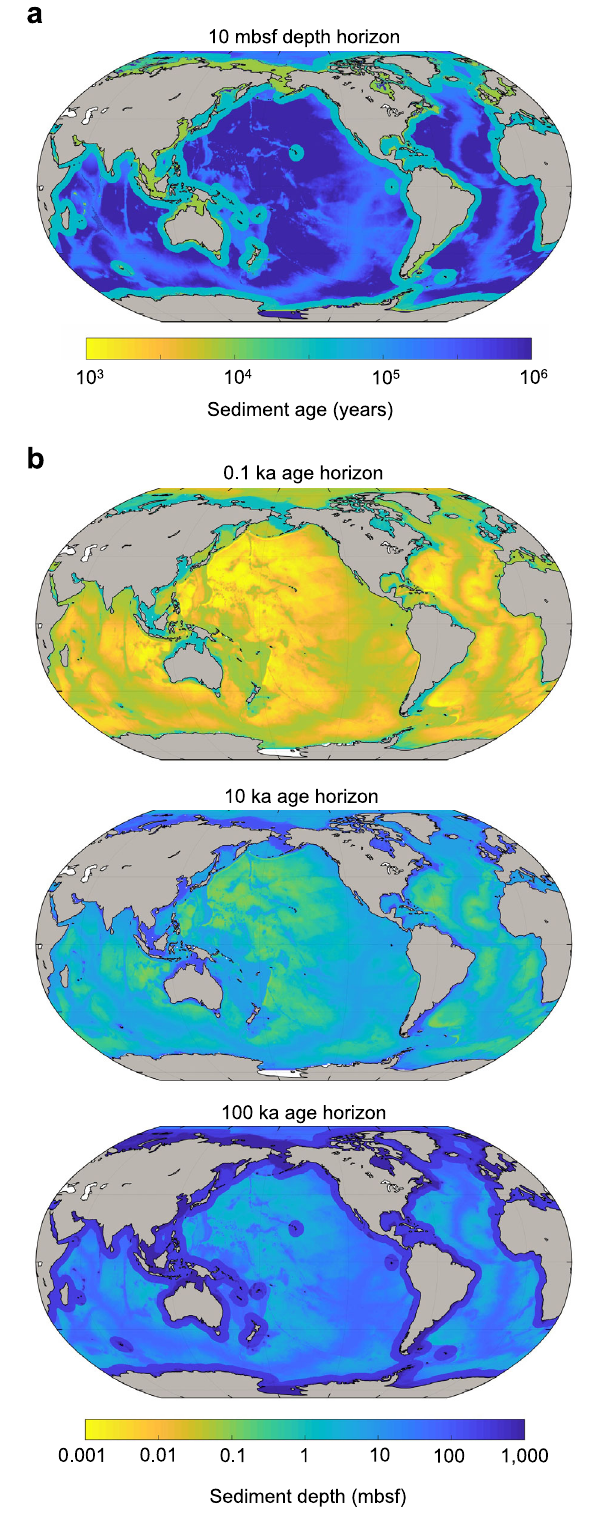
Fig.2|Sedimentagesanddepthsatspeci fi chorizons.a Estimatedsedimentage (i.e.,thetimeelapsedsinceitsdepositionattheSWI)at10mbsf.Theestimatedage of sediment at 10 mbsf varies by over three orders of magnitude globally. b Estimated sediment depth (mbsf) at horizons of equal sediment ages: 0.1 ka, 10 ka, and 100 ka. For a fi xed sediment age, sediment depth beneath the sea fl oor varies globally by over three orders of